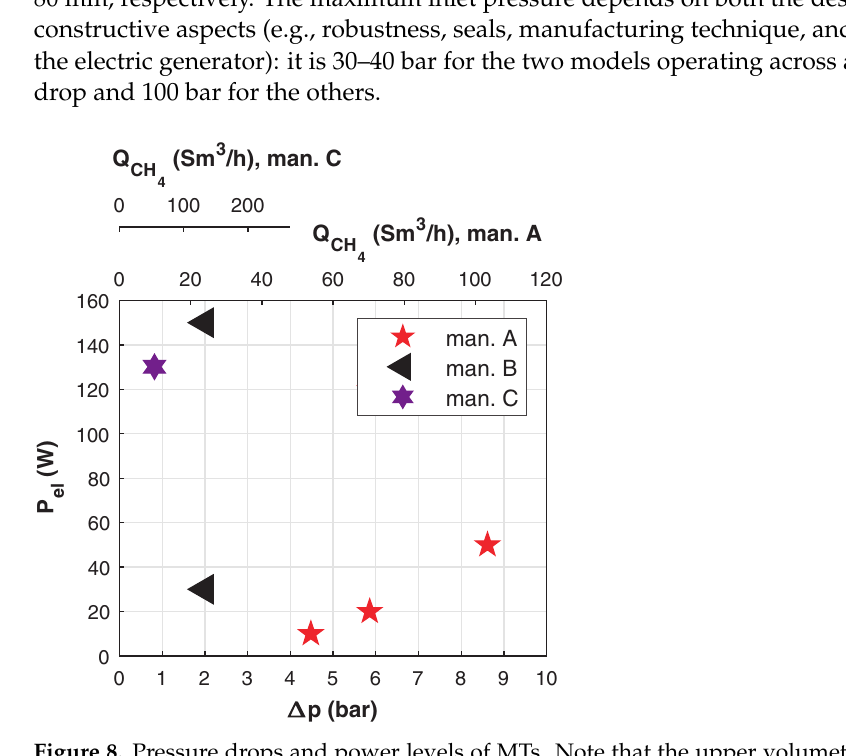
Figure 8. Pressure drops and power levels of MTs. Note that the upper volumetric flow rate axis refers only to “man. A”